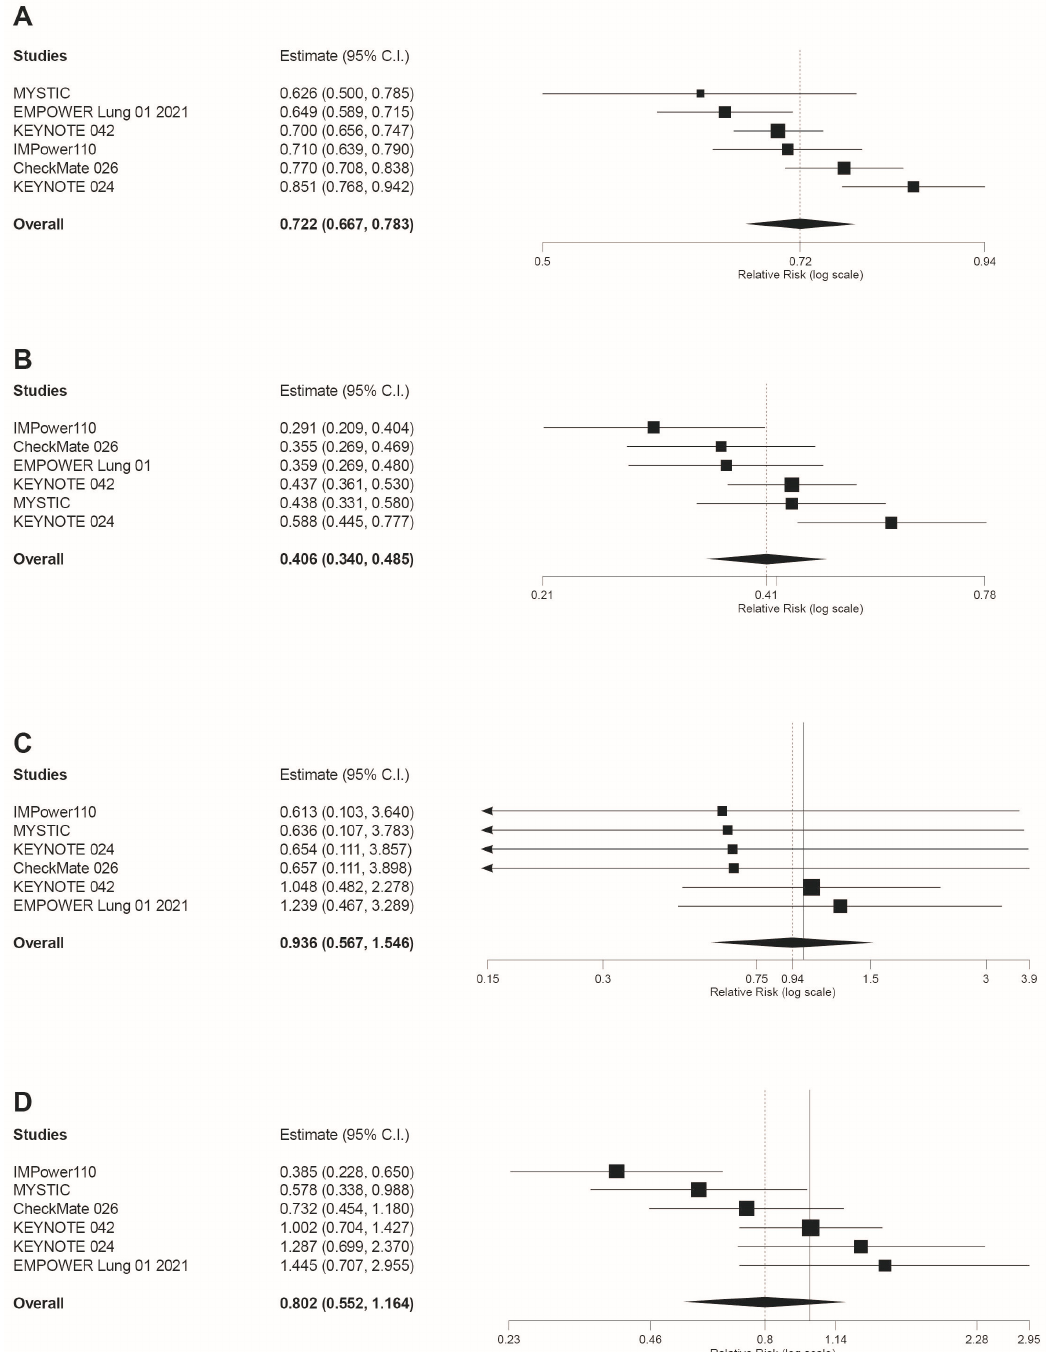
Figure 2. Forest plots of risk ratios (RR) for: ( A ) any grade trAEs; ( B ) trAEs grade >3; ( C ) Grade 5 trAEs; and ( D ) AEs leading to treatment discontinuation in patients treated with anti-PD-1 or anti-PD-L1 immunotherapy compared to platinum-based chemotherapy. Estimate, RR; CI, confidence interval. Treatments are ordered from top to bottom by lower to higher RR in each MA. Black squares indicate the weight of each RCT in the MA. The black rhomb indicates the weighted overall RR for immunotherapy versus chemotherapy. The I 2 index values measuring the heterogeneity of effect-size estimates from the individual studies in MAs A to D correspond respectively to: (I 2 = 74.15%, p = 0.002); (I 2 = 61.78%, p = 0.023); (I 2 = 0%, p = 0.954); and (I 2 = 67.83%, p = 0.008).